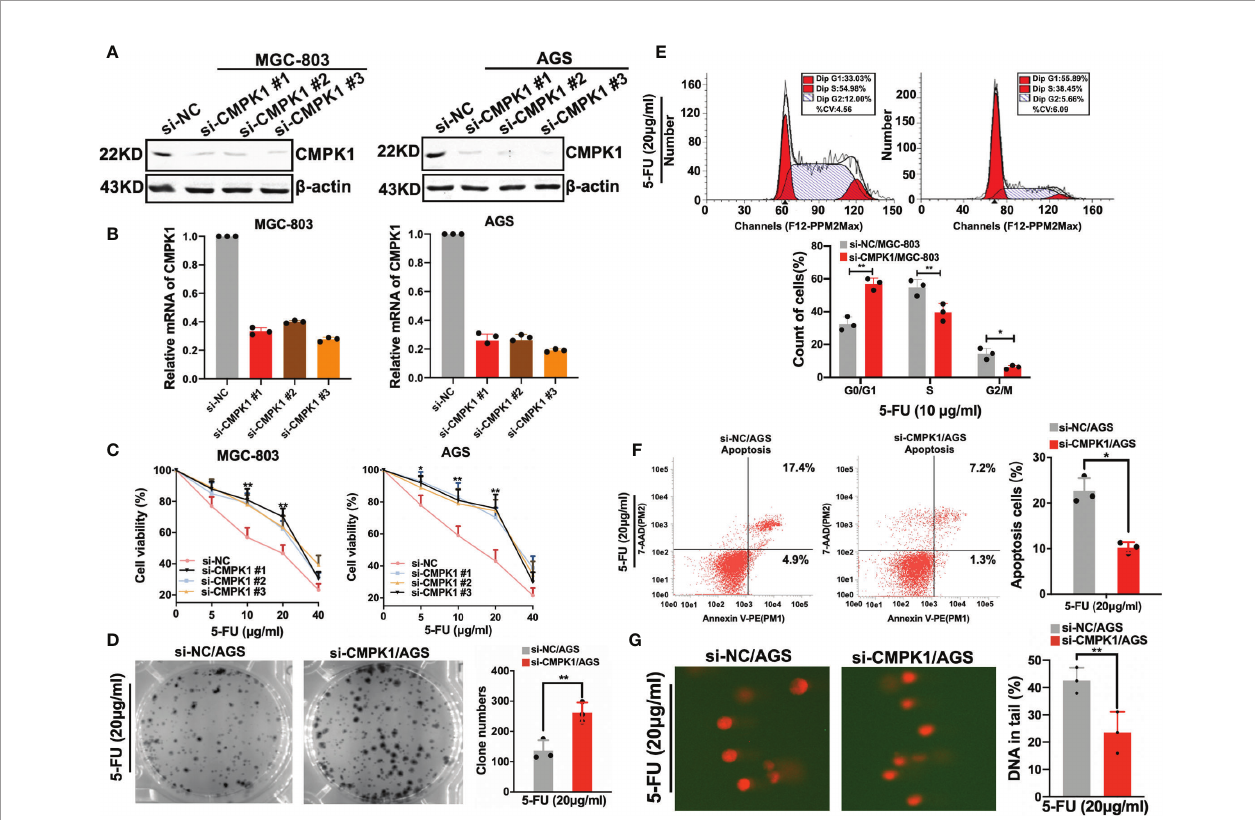
FIGURE 2 | CMPK1 affects gastric cancer cell line sensitivity to 5-FU treatment. (A, B) AGS and MGC803 cells were transfected with 20 nM si-NC or si-CMPK1. After 48 h, cells were harvested for western-blot analysis (A) or RT-qPCR experiments (B) . (C) Cell viability of si-NC and si-CMPK1 with5-FU treatment was tested by MTT assay. (D) 5-FU sensitivity detection was re-con fi rmed in clonogenic cell-survival assay. (E, F) Apoptosis and cell-cycle analysis were pre-treated as previously described and measured by fl ow cytometry to determine the impact of CMPK1 treated with or without 5-FU. The representative fl ow cytometry patterns of cell cycle distribution and the statistical analysis was shown in (E) . The representative fl ow cytometry patterns of cell apoptosis and the statistical analysis was shown in (F) . (G) Knock-down of CMPK1 suppressed 5-FU-induced DNA damage determined by comet assay in AGS cells. Data are presented as mean ± SD of three independent experiments. *P < 0.05, **P <